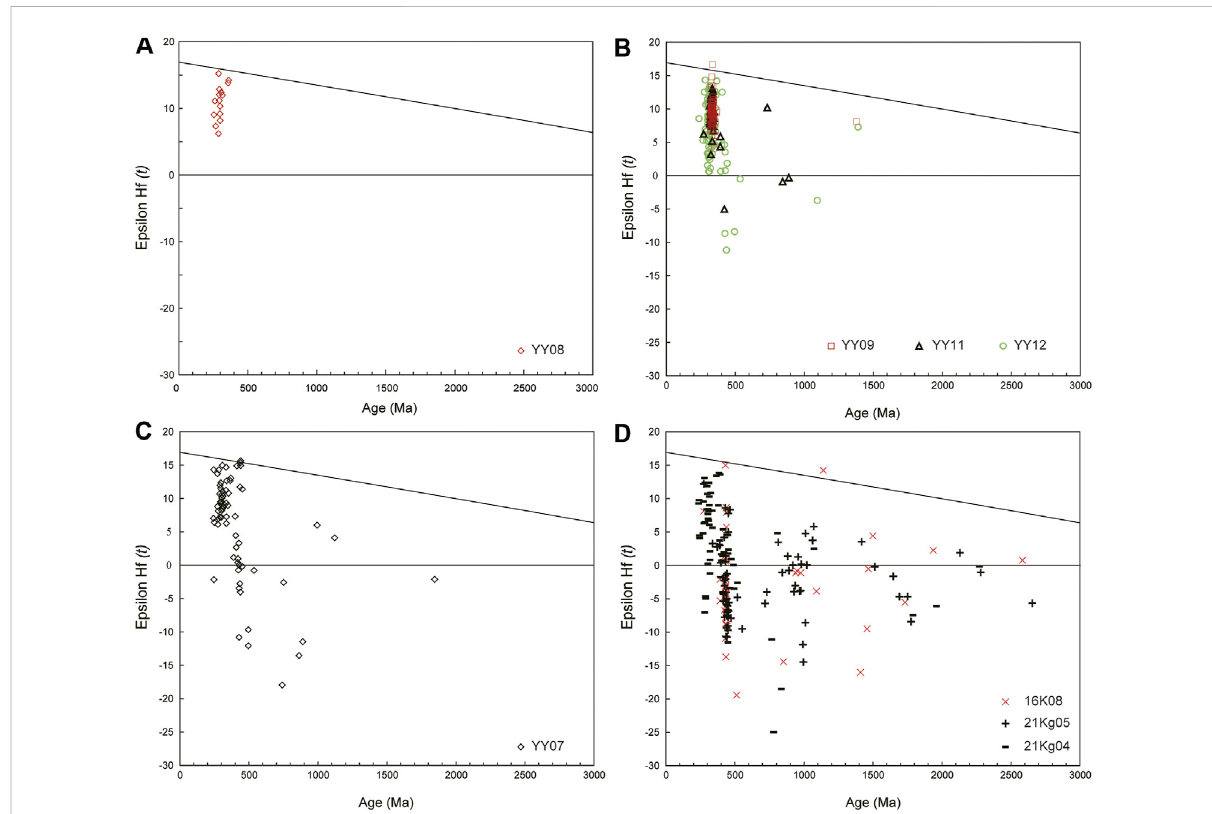
FIGURE 7 Hfisotopediagramsofdatedsamples. (A) BasaltfromthenorthernHLarea. (B) SamplesYY09andYY11inthenorthernHLareashowingthatthe sandstone sampleswereprobablyderivedfromtheDananhuintraoceanicarctothenorth. (C) Samples YY07 andYY12 inthenorthernHLareashow asmallamountofmaterialsourcedfromtheYamansu-centralTianshanarctothesouth. (D) Samples16K08, 21Kg04and21Kg05inthesouthernHL area showing that the sandstones were probably derived from the Yamansu-central Tianshan arc to the south. The age data after Supplementary Table